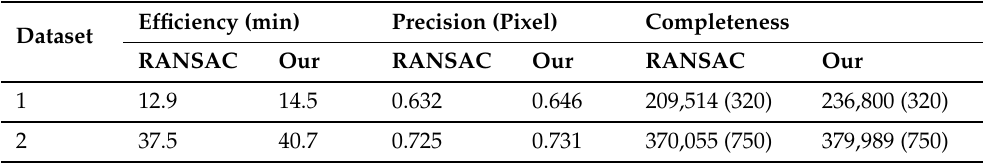
Figure 21. The illustration of feature matching of image pairs from UAV datasets. The values in the bracket indicate the number of matches before and after outlier removal. Table 3. The statistical results of SfM-based image orientation for the two UAV datasets in terms of efficiency, completeness, and precision. The values in the bracket indicate the number of connected images in the final